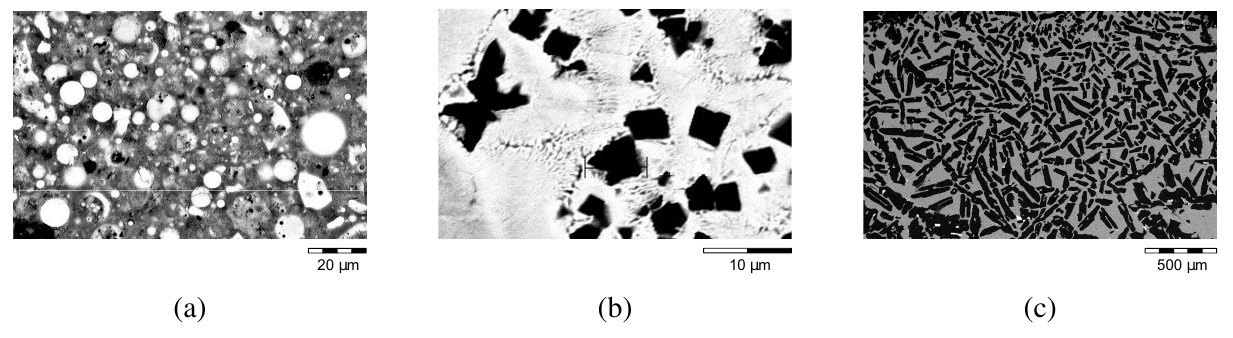
Figure 1. Examples of micro-graphs of real engineering materials taken in back scattered electrons: ( a ) Alkali-activated fly ash, ( b ) Alumino-silicate ceramics with Fe and silicium particles (dark phase), ( c ) Superspeed—alloying ingredient into crude iron for cast